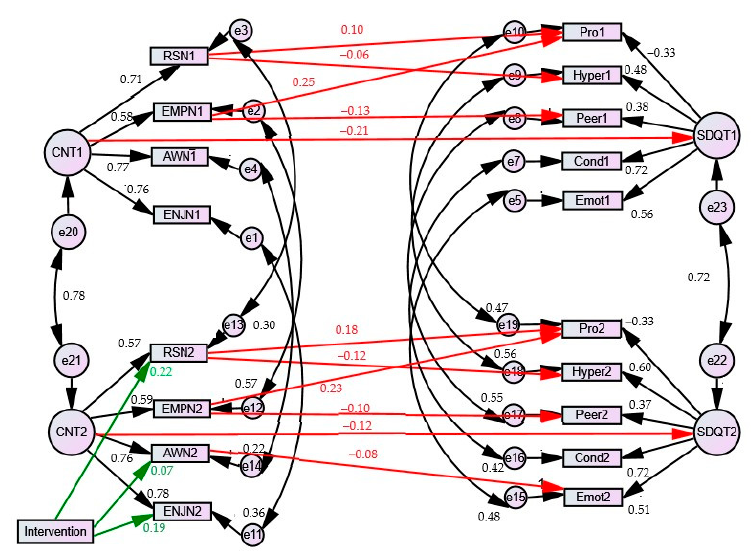
Figure 1. CNI as predictor of SDQ score. Green when positive; R2 values for SDQ scores displayed. The fit of this model is good. χ 2 = 331.64, df = 128, χ 2 / df = 2.59, p = 0.11; CFI = 0.95; gamma hat = 0.97; RMSEA = 0.051 (90% CI = 0.044–0.058, p close = 0.39); SRMR = 0.052. Intervention Status = Interven- tion as a predictor variable; Pro1, Pro2 = Before/After intervention score of children’s ProSocial behaviors; Hyper1, Hyper2 = Before/After intervention score of children’s Hyperactivity; Peer1, Peer2 = Before/After intervention score of children’s Peer problems; Cond1, Cond2 = Before/After intervention score of children’s Conduct Problems; Emot1, Emot2 = Before/After intervention score of children’s Emotional problems; EMPN1, EMP2 = Before/After intervention score of Empathy for nature; RSN1, RSN2 = Before/After intervention score of Responsibility towards nature; ENJN1, ENJN2 = Before/After intervention score of Enjoyment of nature; AWN1, AWN2 = Before/After intervention score of Awareness of